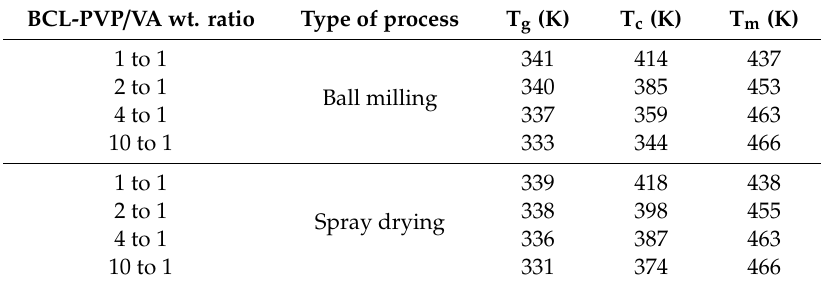
Figure 4. DSC thermograms of solid dispersions containing bicalutamide and KollidonVA ® 64 obtained by either spray drying (solid lines) or ball milling (dotted lines). Table 3. Comparison of the T g , T c , and T m values of solid dispersions containing bicalutamide and Kollidon ® VA64 obtained by either ball milling or spray drying.